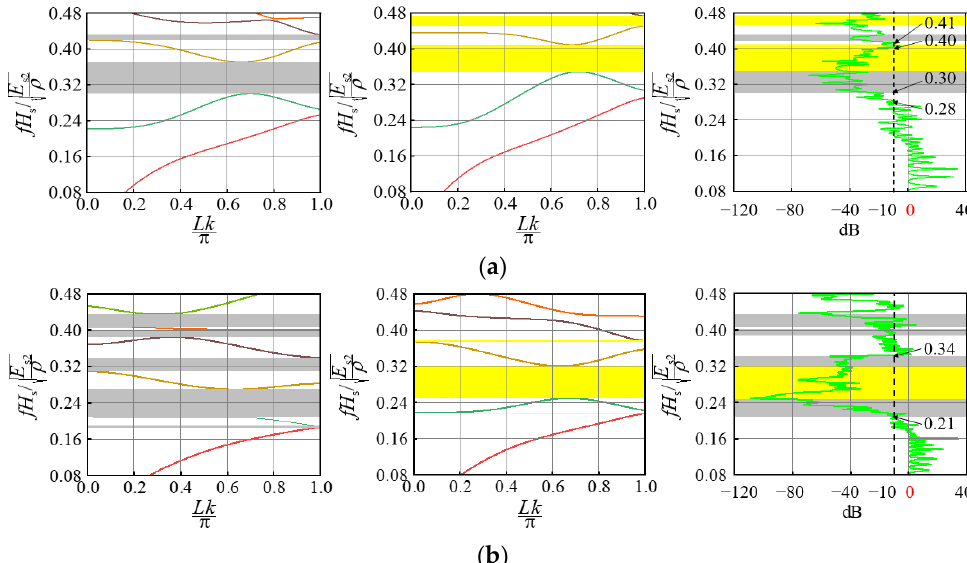
Figure 6. Influence of thickness ratio H f / H s on the band gap: ( a ) 4.0 × 10 − 2 and 3.0 × 10 − 2 ; ( b ) 7.0 × 10 − 2 and 5.0 × 10 − 2 .